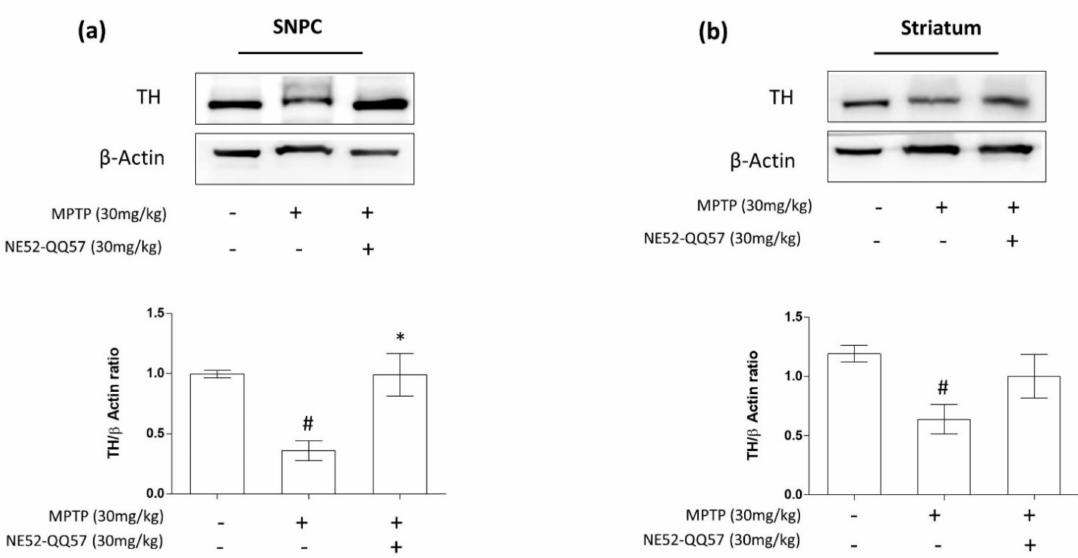
Figure 2. The effects of the GPR4 antagonist NE52-QQ57 on TH protein expression levels in MPTP-treated mice. MPTP was administered (30 mg/kg/day) for 5 days. Mice were sacrificed, and the substantia nigra and striatum tissues were collected 3 days after the final MPTP administration. ( a ) TH protein expression in the SNpc region of the mouse brain ( n = 3) and densitometric analysis. ( b ) TH protein expression in the striatum region of the mouse brain ( n = 3) and densitometric analysis. β -Actin was utilized as an internal control. Data represented the mean ± SEM. One-way ANOVA, followed by Tukey’s multiple comparison test, was used to compare differences between groups. # p < 0.05 when the MPTP-treated group was compared with the vehicle-only group; * p < 0.05 when other treated groups were compared with the MPTP-treated